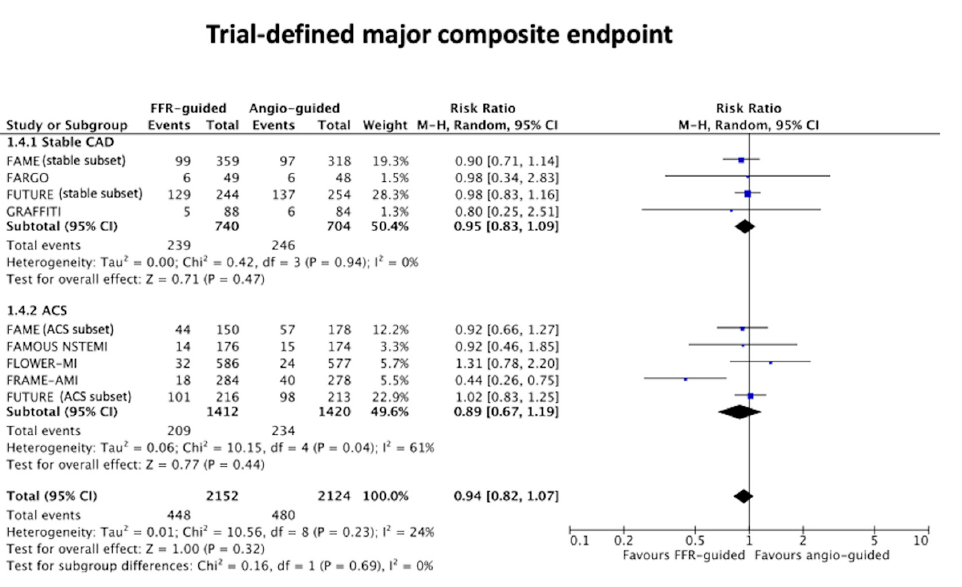
Figure 3. Forest plot of the trial-defined composite endpoint stratified by stable CAD and ACS.